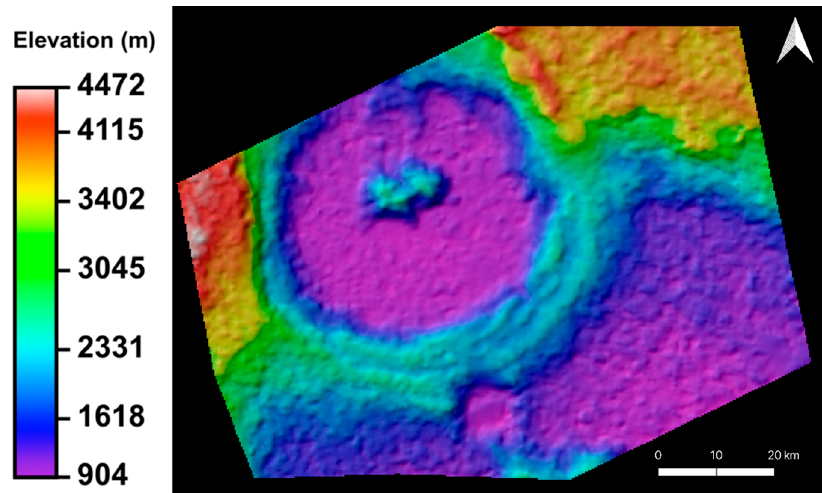
Figure A5. Kertész Crater.